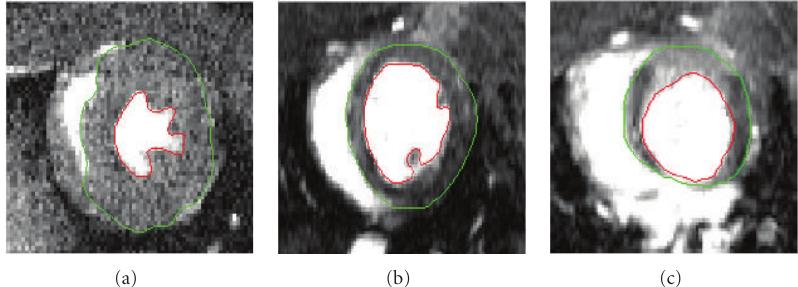
Figure 1: Myocardial segmentation. Green line marks the epicardial border while red line marks endocardial border. ES (a) and ED (b) images illustrate papillary muscles segmented as part of myocardium. The last image (c) illustrates the straight line used to connect the two ends of the